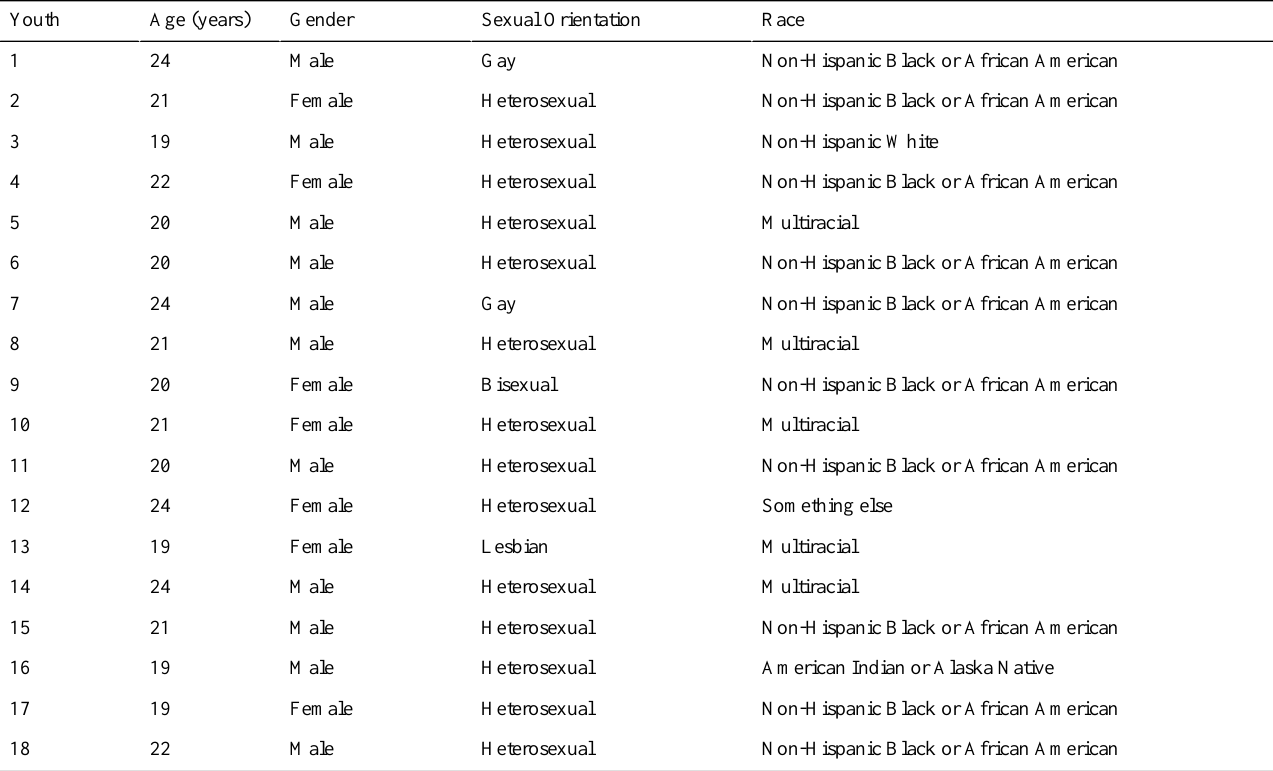
Table 1. Characteristics of youth experiencing homelessness (YEH)